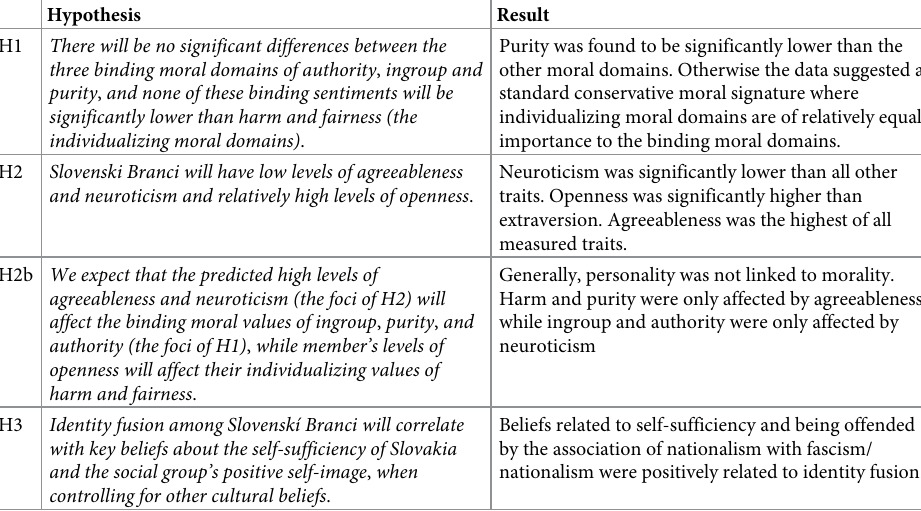
Table 6. Chart of hypotheses and results. Hypothesis Result